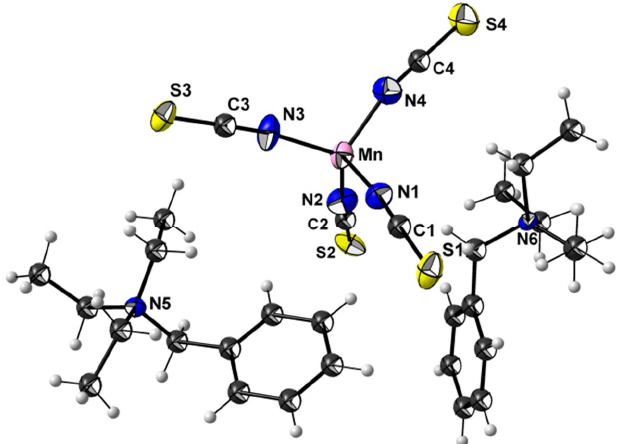
Figure 2. Molecular structure of (BnEt 3 N) 2 [Mn(NCS) 4 ] with labeling of selected atoms. Thermal displacement ellipsoids are drawn at the 50% probability level.